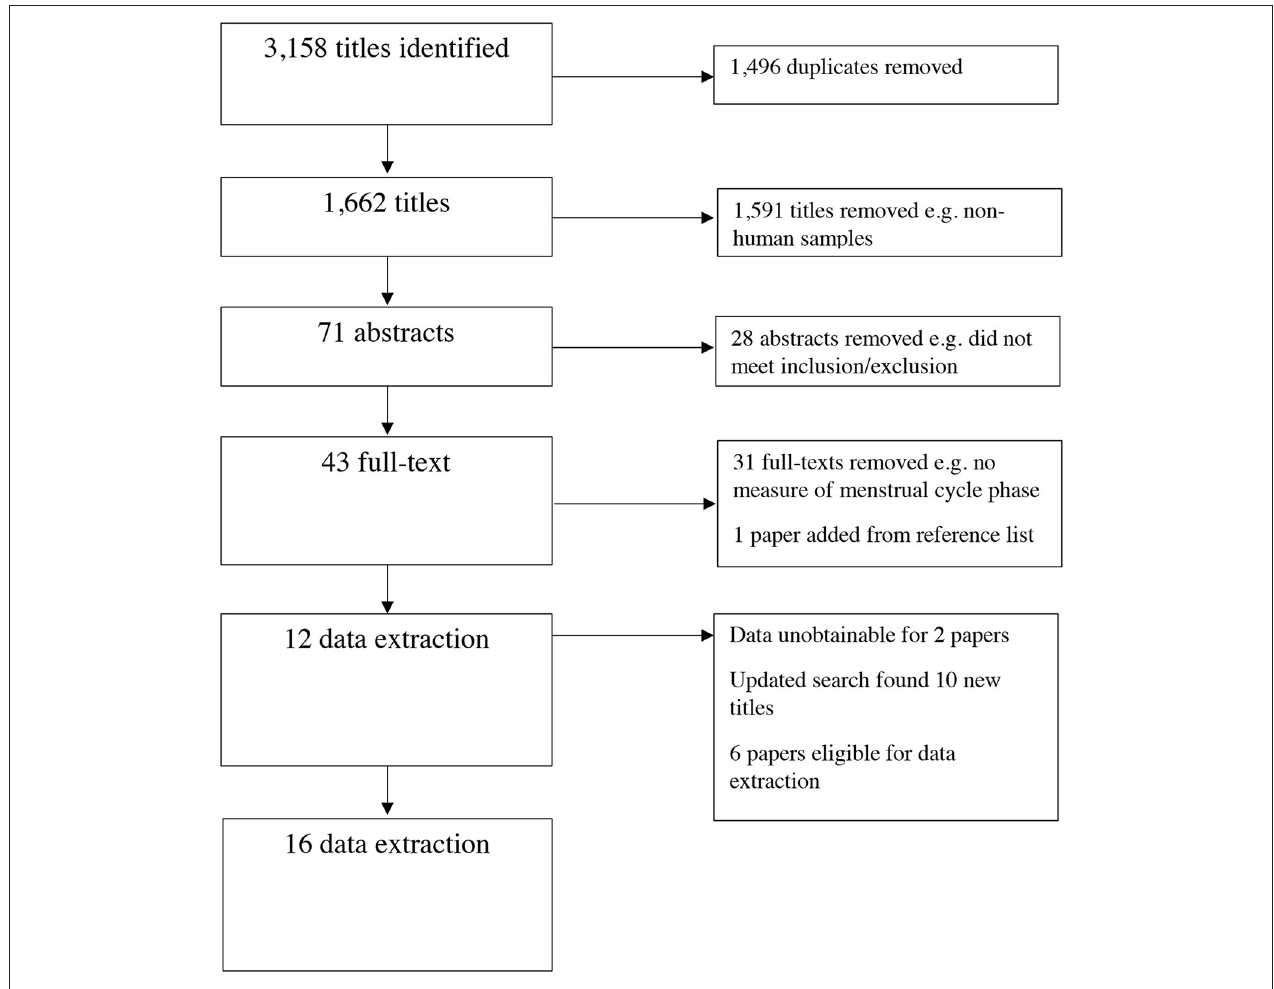
FIGURE 2 | PRISMA flow